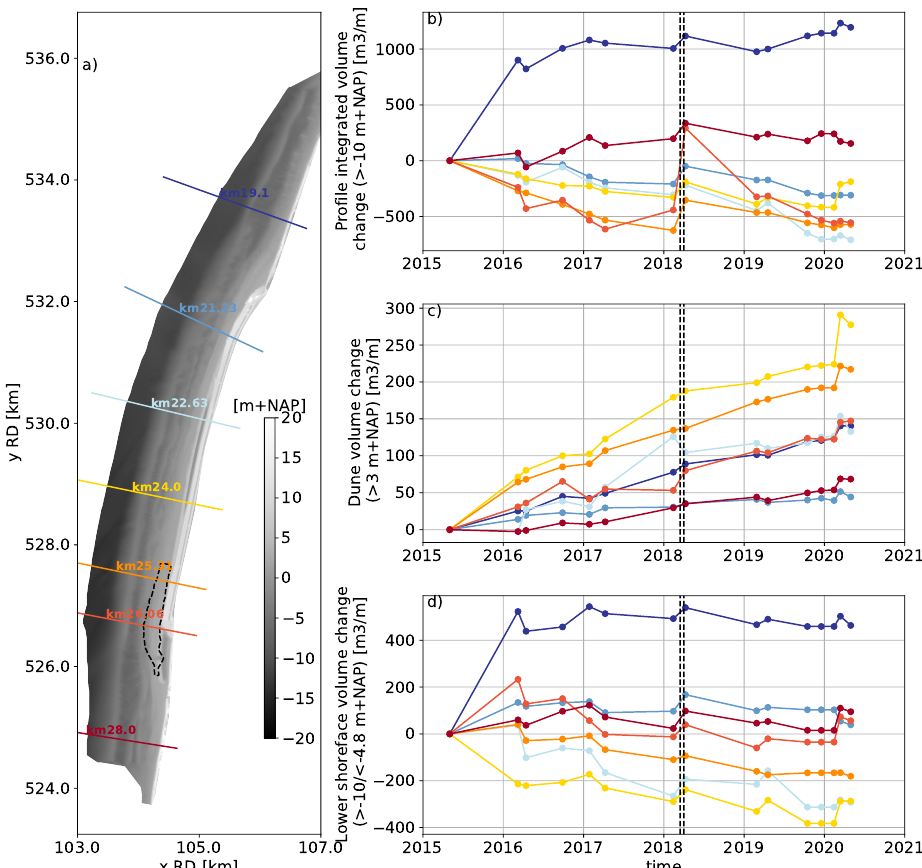
Figure 8. Volume change over time for transects at km 19.1, 21.23, 22.63, 24, 25.31, 26.06, and 28. ( a ) Location of transects (colored lines) and 2018 nourishment (dashed contour), ( b ) Profile-integrated volume change (> − 10 m + NAP), ( c ) Dune volume change (>3 m + NAP), and ( d ) lower shoreface volume change (between − 10 and − 4.8 m + NAP). The black dotted vertical lines indicate the period of the additional 2018 beach nourishment between km 25 and